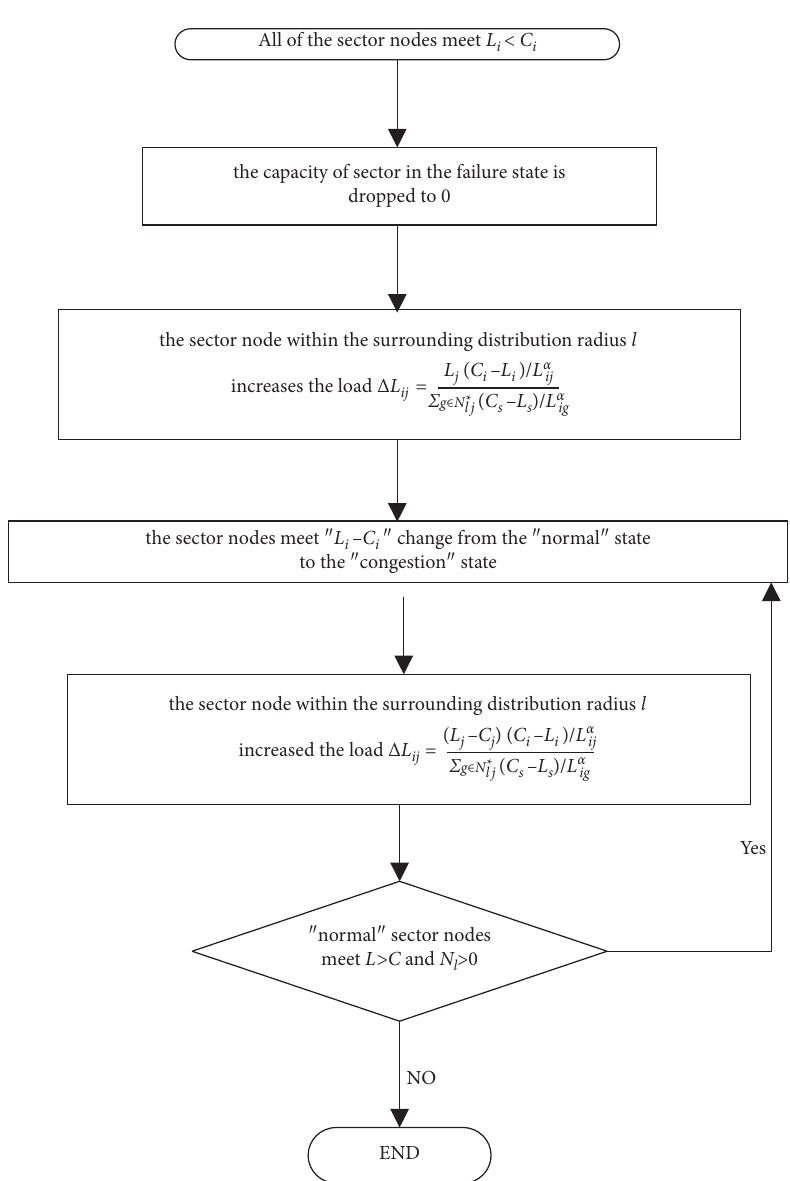
Figure 4: The flowchart of the prejudged partial load redistribution strategy based on the nodes’ remaining